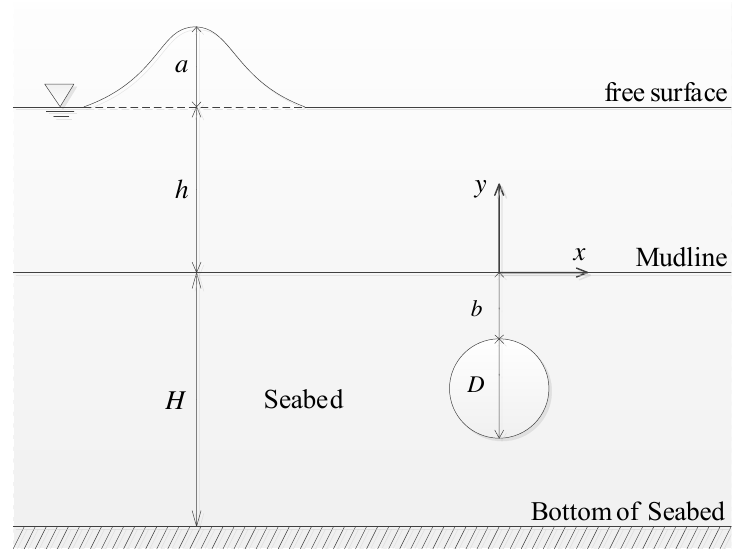
Figure 1. Schematic diagram of research